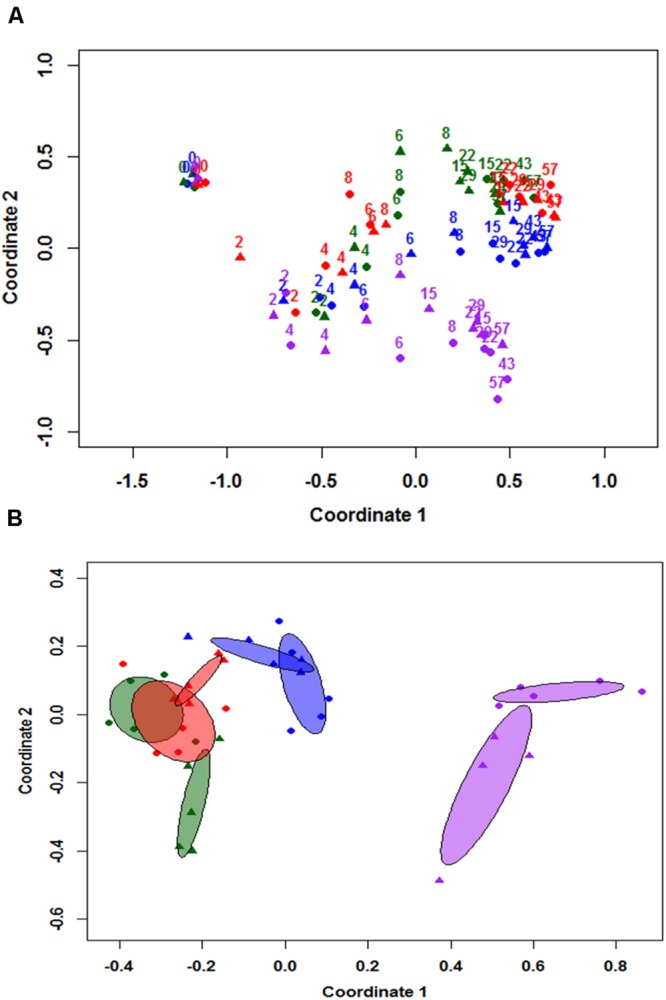
Non-metric multidimensional scaling (NMDS) analysis based on community structure at class level (A), and 95% centroids of days 15–57 samples (B). Numbered labels in figure (A) represent sampling day and colors apply to both figure (A,B). Blue = duplicate cowpats from unshaded farm 1 (U1), Purple = duplicate cowpats from unshaded farm 2 (U2), Green = duplicate cowpats from shaded farm 1 (S1), Red = duplicate cowpats from shaded farm 2 (S2). Circle (•) and triangle (▴) symbols represent each duplicate cowpat.